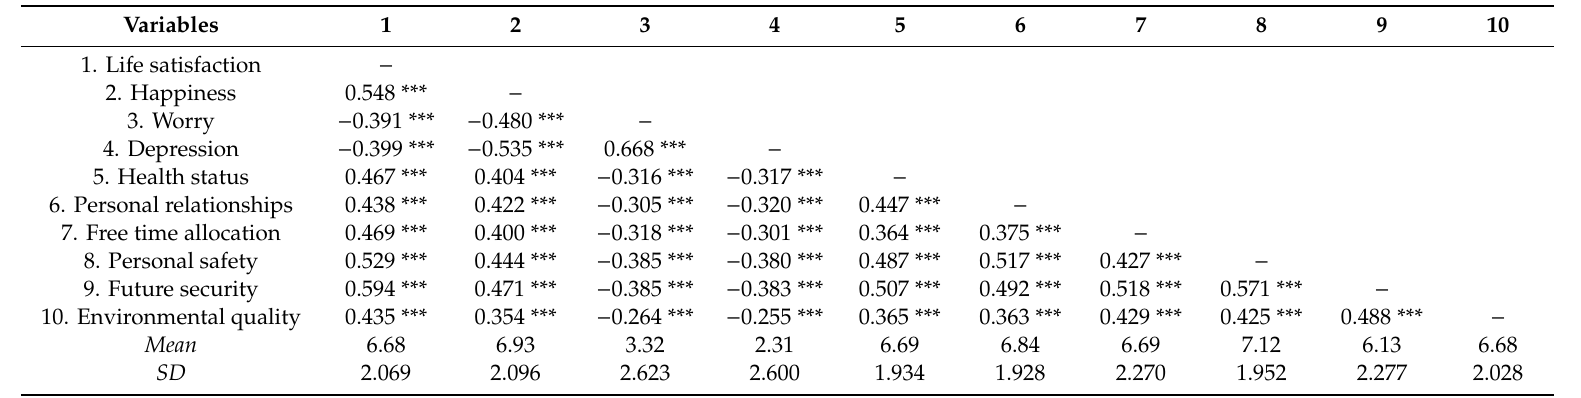
Table 2. Correlation matrix of the socio-demographic characteristics and emotional profiles.